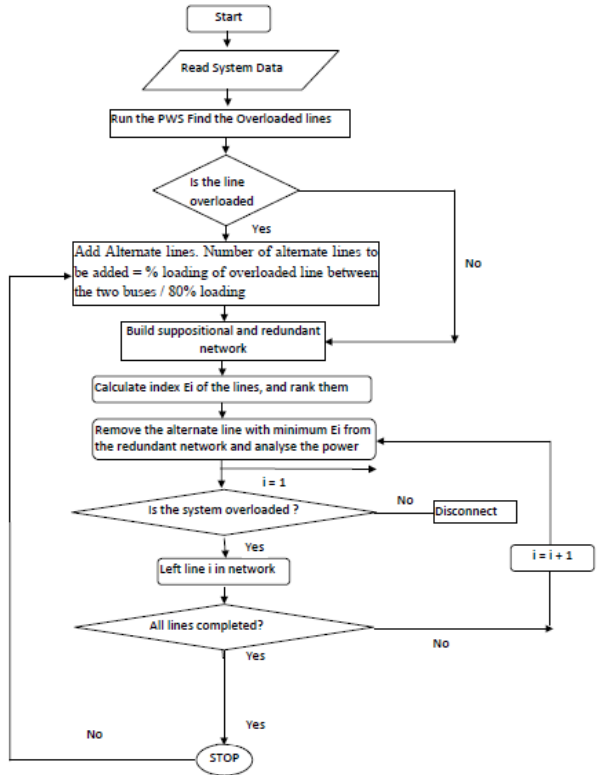
Fig. 3.1 Flowchart for Analytic algorithm for